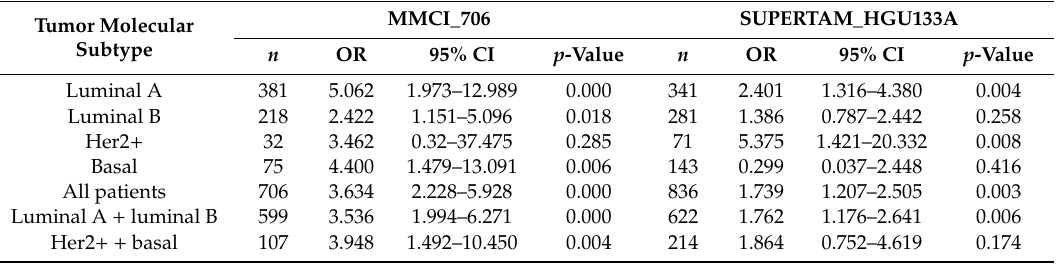
Table 1. Increase of distant metastasis risk dependent on lymph node positivity in patients of four molecular subtypes from MMCI_706 study cohort and SUPERTAM_HGU133A dataset using logistic